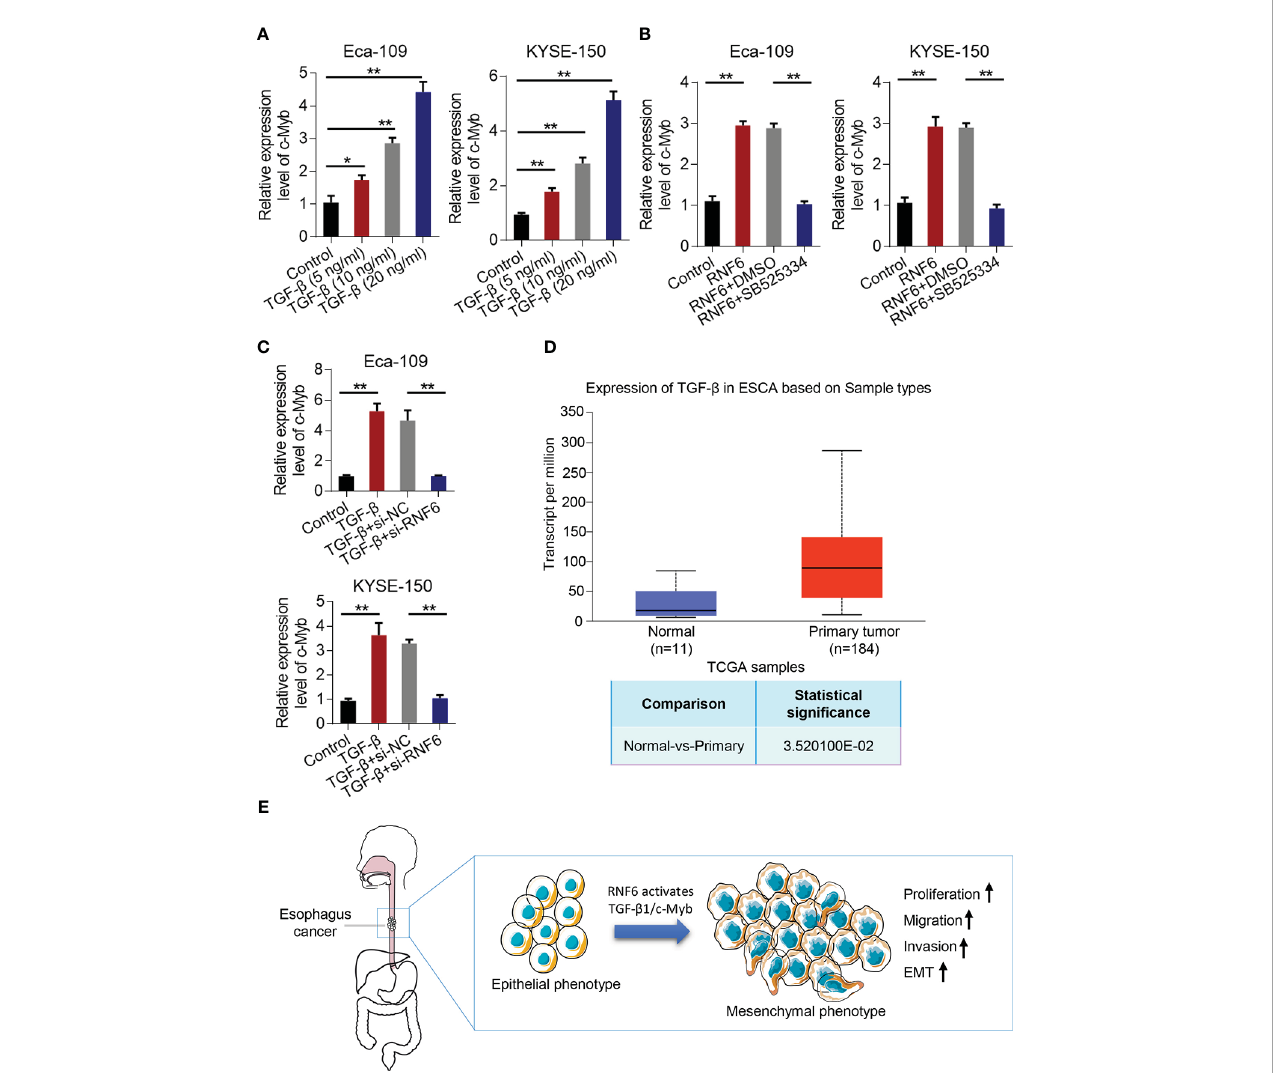
FIGURE 7 RNF6/TGF- b 1 promotes esophageal cancer progression through c-Myb. (A) The level of c-Myb in cells increased after the concentration of TGF- b 1 was increased. (B) qPCR analysis of c-Myb mRNA levels in RNF6 overexpressed or SB525334 (TGF- b inhibitor)-treated Eca-109 and KYSE-150 cells. (C) qPCR analysis of c-Myb mRNA levels in Eca-109 and KYSE-150 cells treated with silenced RNF6 or TGF- b 1. (D) TCGA analysis of the relative levels of TGF- b in adjacent normal tissues and esophageal cancer tissues. (E) Mechanism diagram of RNF6 promoting EMT. n=3, *P <0.05; **P < 0.01, ANOVA